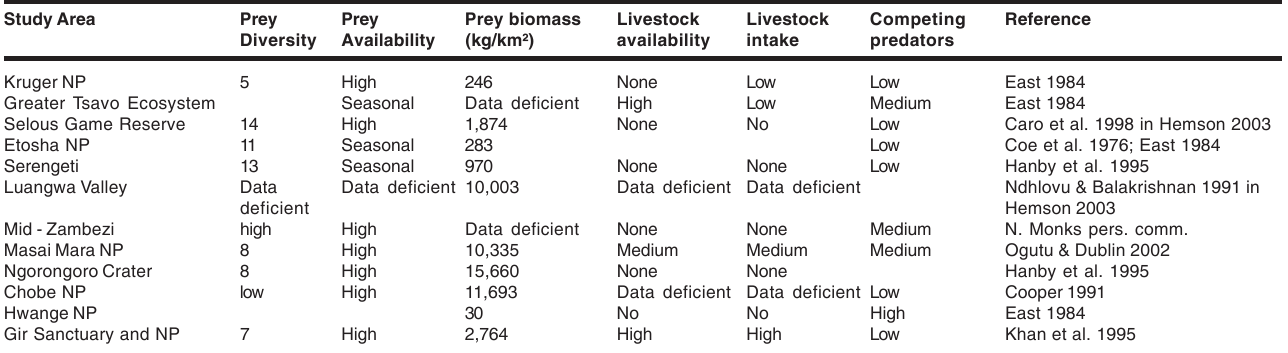
Table 3. Details on prey related parameters and competition for the lion habitats Study Area Prey